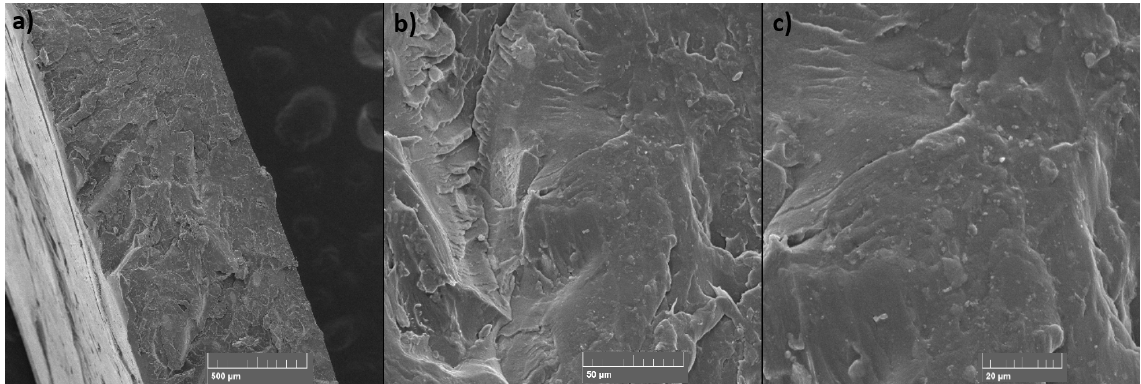
Figure 12. SEM micrographs of the fracture surface for the PET-G 6T 0C sample at ( a ) 100×, ( b ) 1000× and ( c ) 5000× magnification.